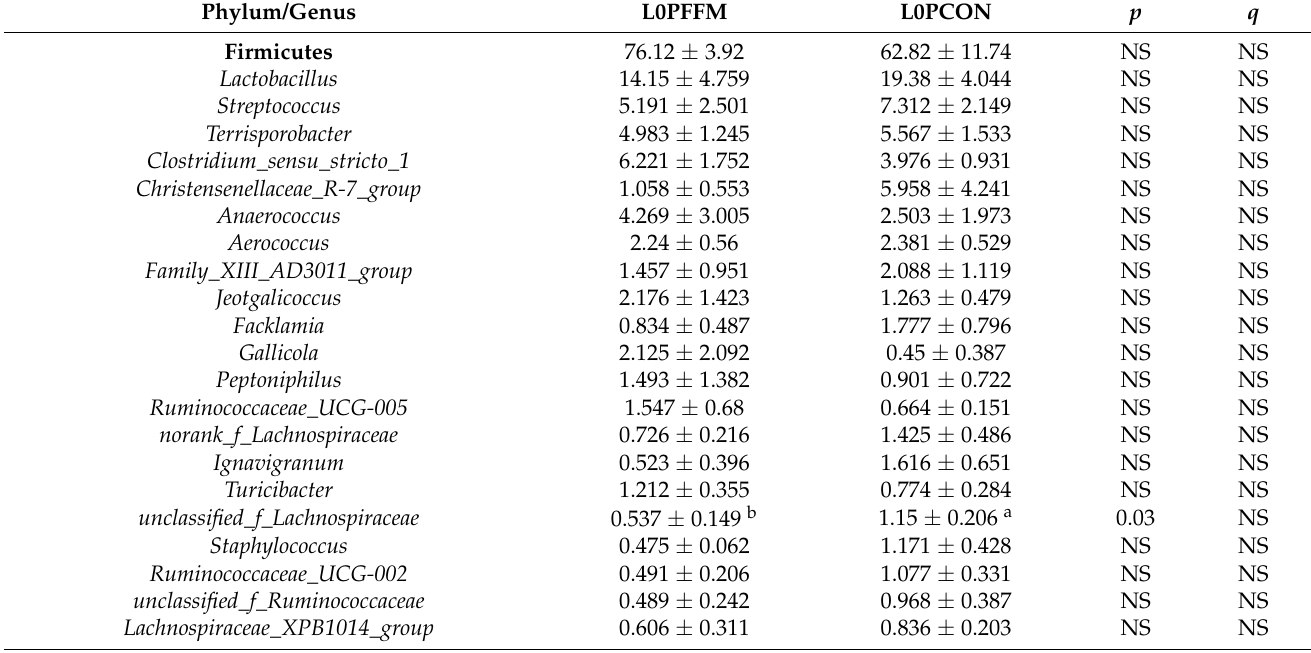
Table 5. Composition of the fecal microbiota of piglets on L0 at the phylum and genus levels.